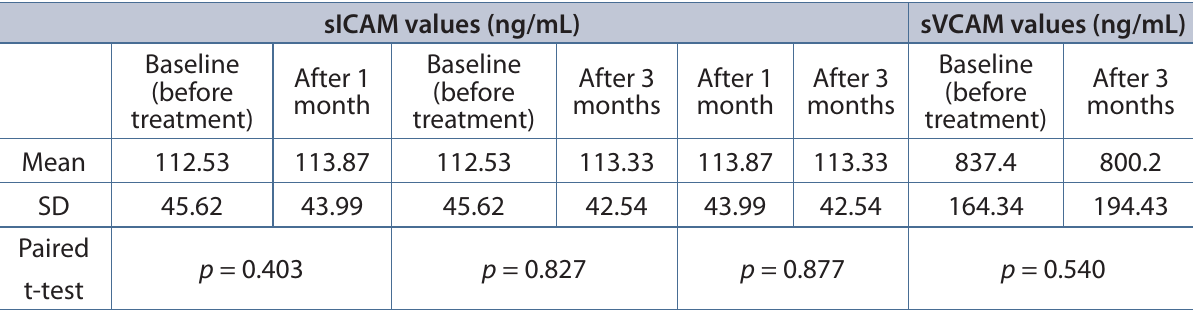
Table 5. Comparison between sICAM and sVCAM values in non-responders at different times of the study sICAM values